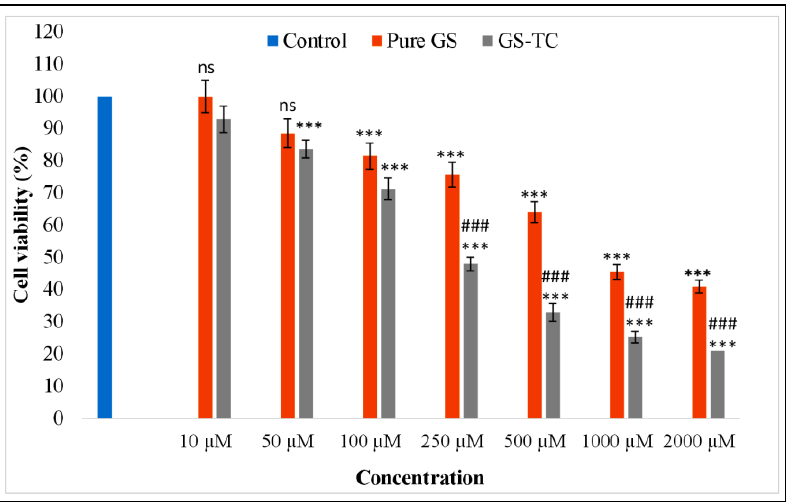
Figure 11. Cytotoxicity study result of Genistein (GS) and prepared genistein ternary complex (GS TC). The data shown as mean ± SD (n=3). Difference was considered significant if p < 0.05. ns = not significant when compared with control; ### p < 0.01 when compared between pure GS and GS TC. *** = p < 0.001 when compared with control.